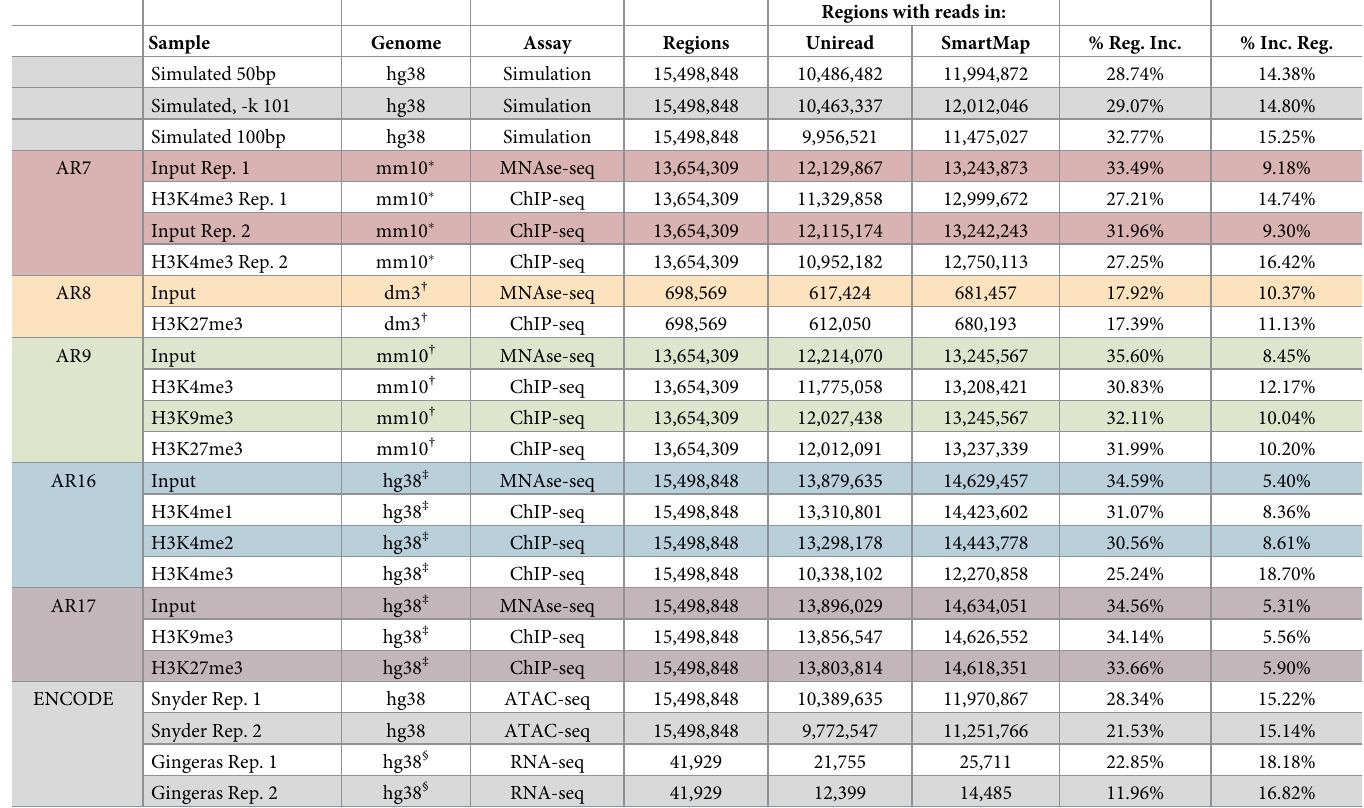
Table 2. Analysis of reads across genomic windows.